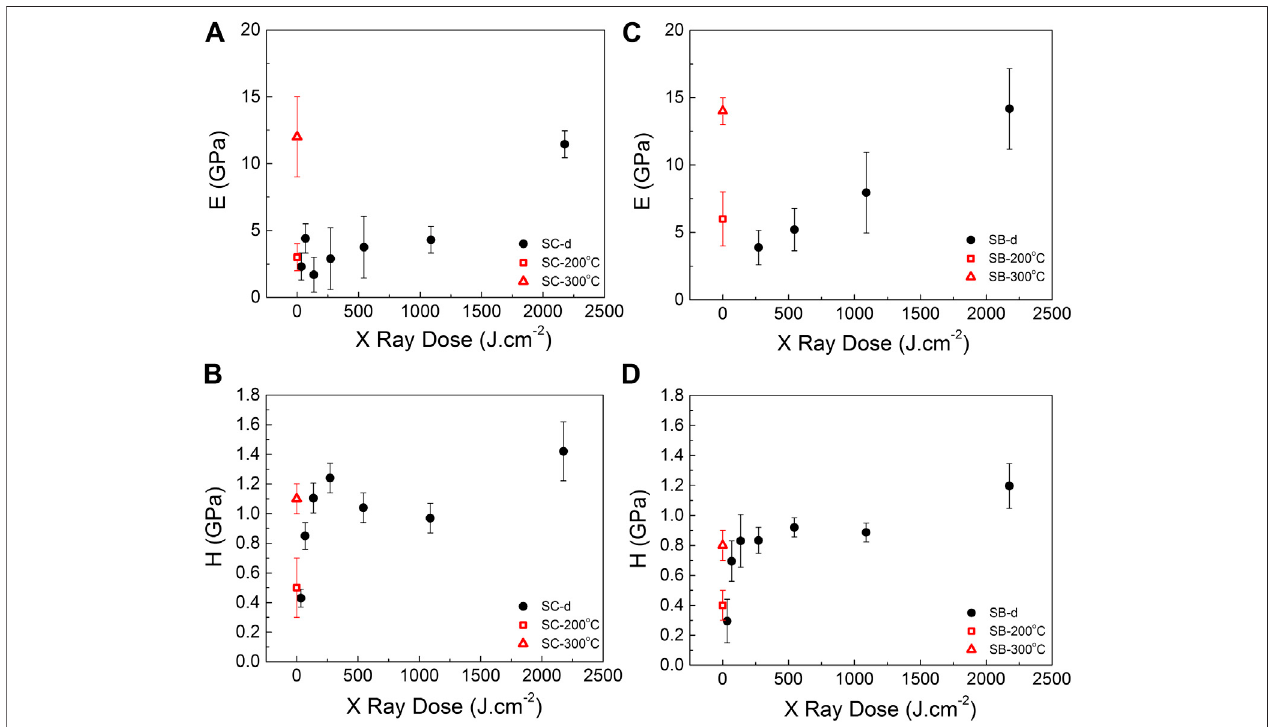
FIGURE6| Indentationmodulus(E)andhardness(H)valuesmeasuredforsamplesirradiatedatdifferentXRdoses(SX-d),for (A,B) SCand (C,D) SBsystems.The values measured for thermally treated fi lms at 200 ° C (squares) and 300 ° C (triangles) are also included.